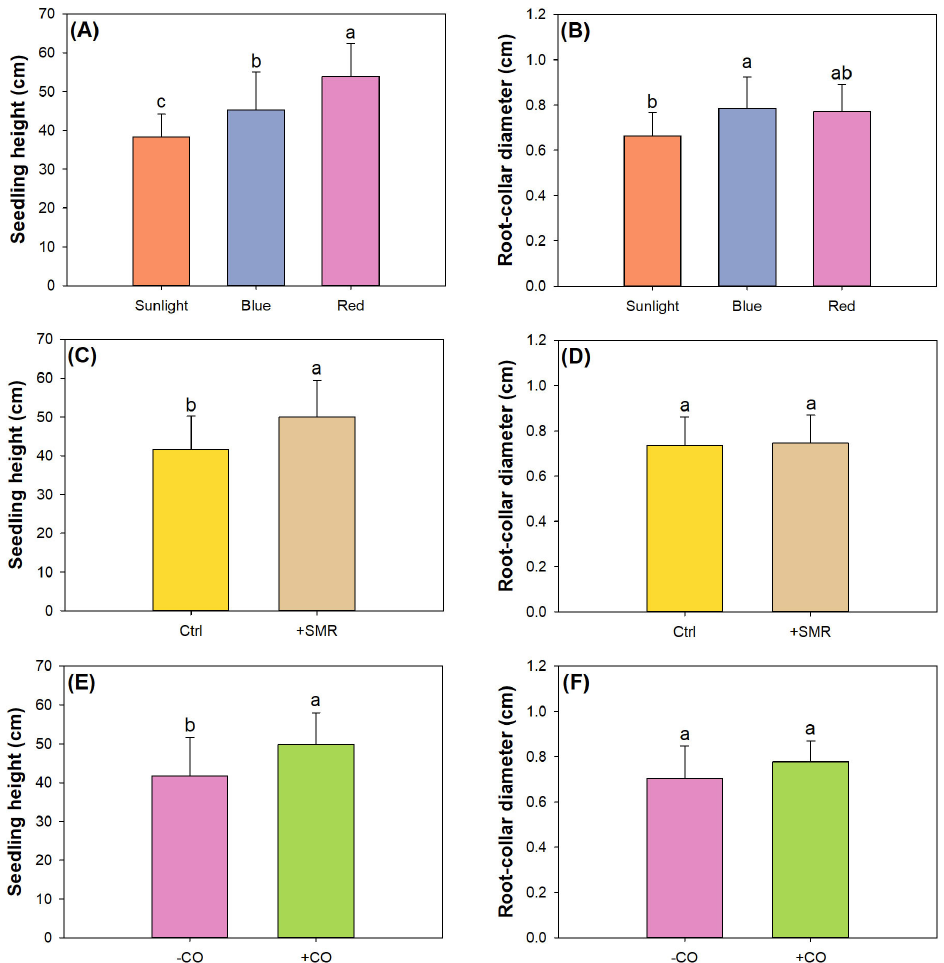
Figure 1. Growth of black chokeberry ( Aronia melanocarpa (Michx.) Elliott 1821) exposed to separate light-type (sunlight, blue light-emitting diode (LED), red LED), chitosan oligosaccharide (CO), and spent mushroom residue (SMR) treatments: ( A ) light effect on seedling height; ( B ) light effect on root-collar diameter; ( C ) SMR effect on seedling height with unamended soils as the control (Ctrl); ( D ) SMR effect on root-collar diameter with unamended soils as the control (Ctrl); ( E ) CO effect on seedling height; ( F ) CO effect on root-collar diameter. Different letters mark significant difference according to Tukey test at 0.05 level.